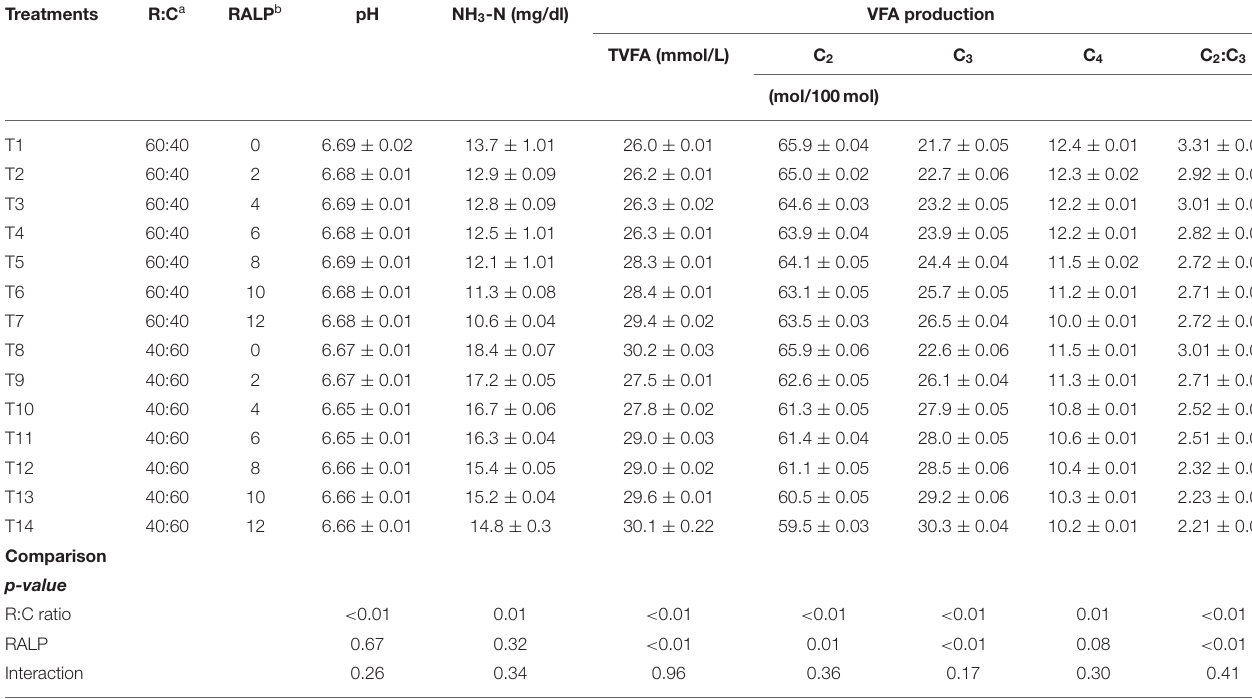
TABLE 3 | Effect of RALP supplementation on rumen fermentation characteristics.